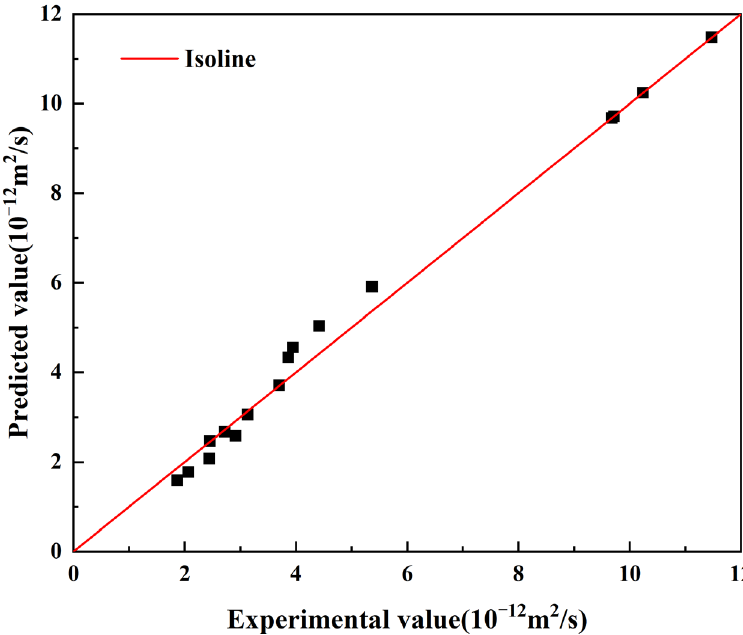
Figure 10. Comparison between the measured and predicted apparent chloride diffusion coefficient. Table 5. F-test results of the model of apparent chloride diffusion